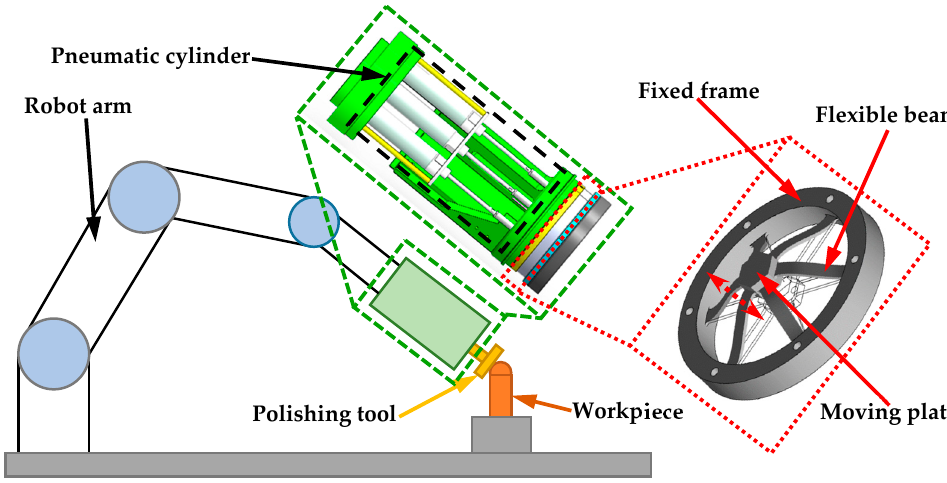
Figure 1. Schematic diagram of the proposed CEE installed on an industrial robot arm.